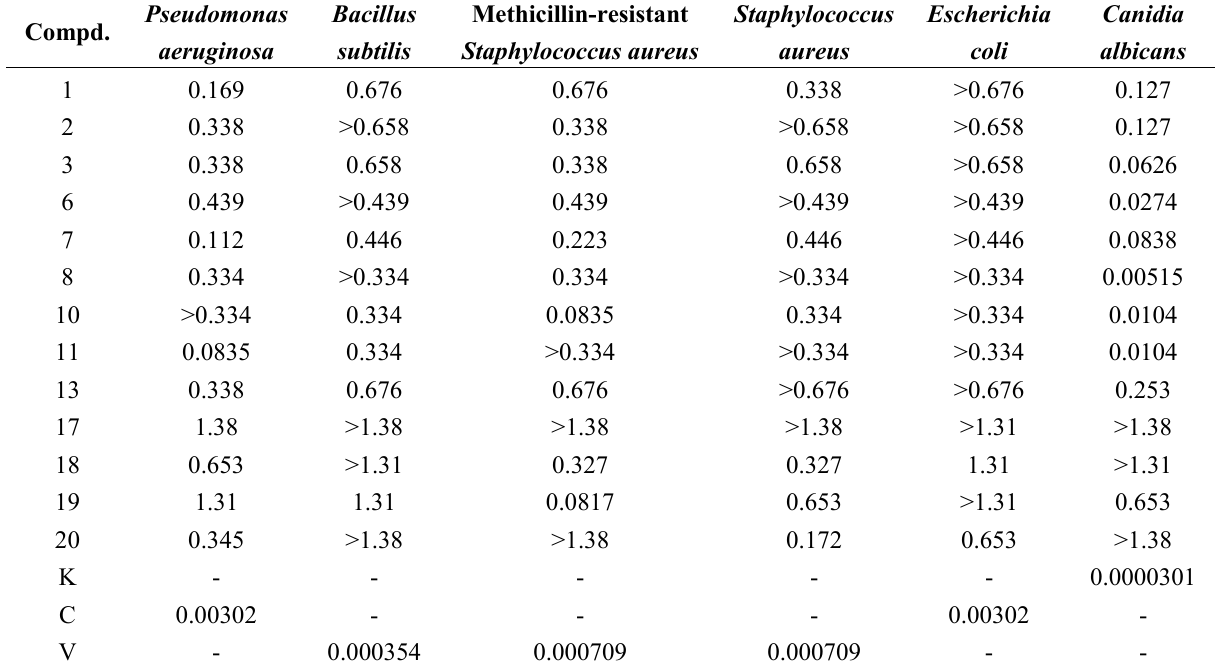
Table 4. Minimum inhibitory concentrations MIC (mM) of the constituents of E. sinica